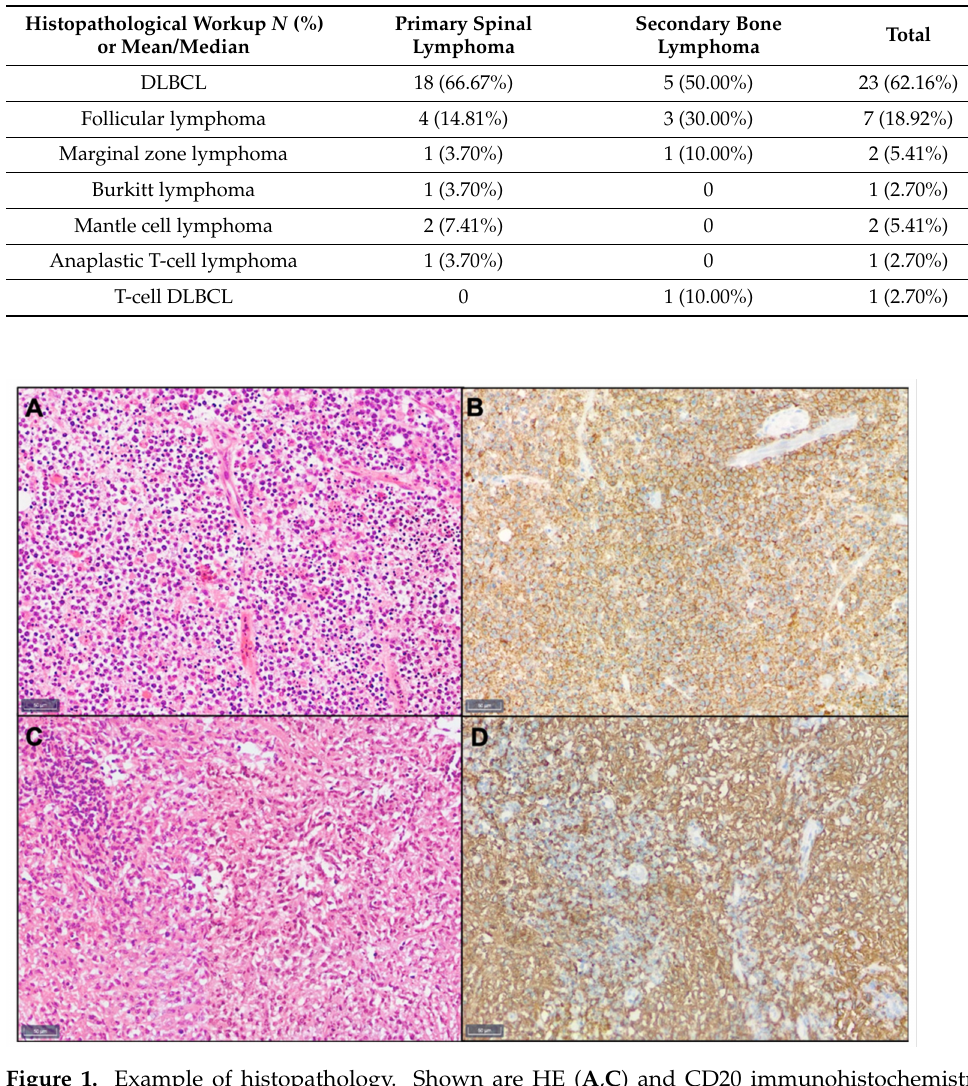
Table 5. Histopathological diagnosis divided according to frequency. DLBCL: diffuse large B- cell lymphoma.